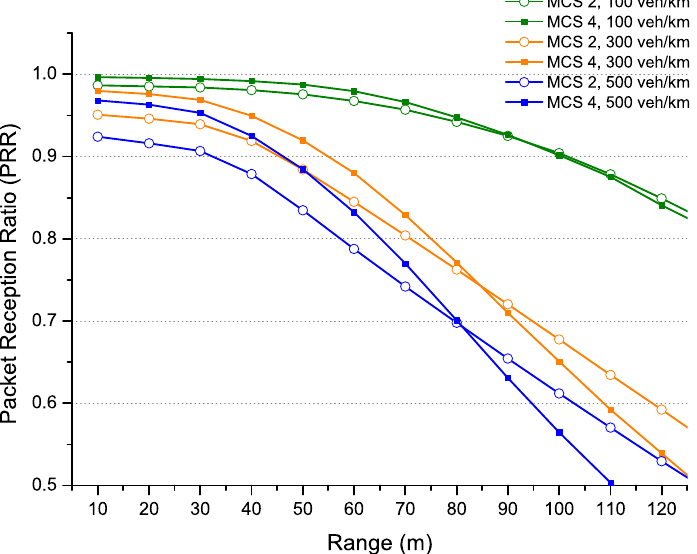
Figure 17. Example of mixed traffic (combined with CAM, DENM, CPM) for